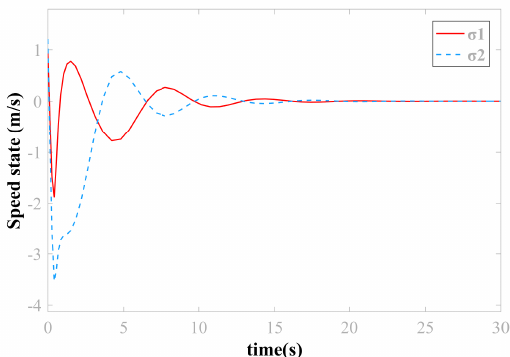
Figure 4. Surge speed state of two ships ( σ 1, σ 2 ) .